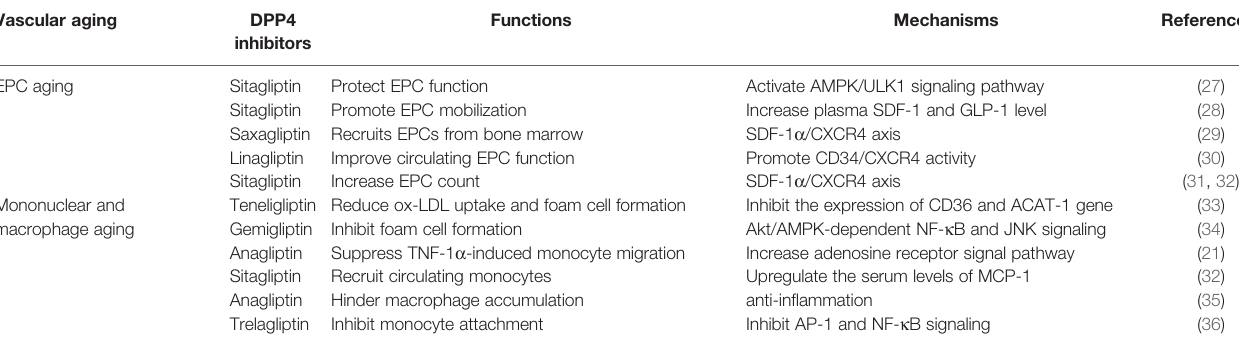
TABLE 3 | DPP4 inhibitors associated with vascular function and mechanisms in EPCs and mononuclear macrophage aging. Vascular aging